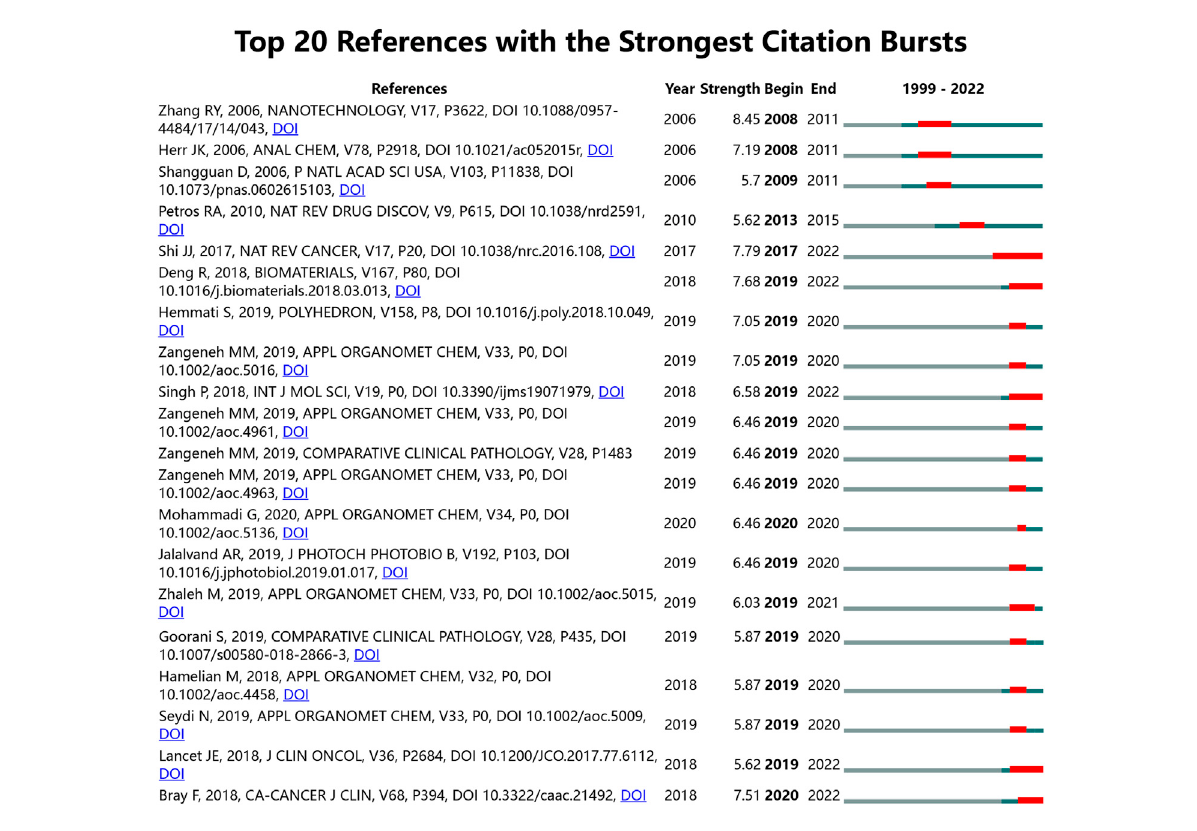
FIGURE 9 Top 20 references with the most powerful citation bursts (sorted by the strength). Notes: The Blue bars mean the published reference; the red bars mean citation